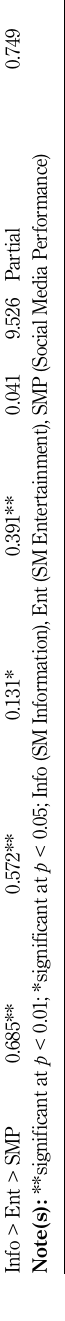
Table 7. Mediation of social media